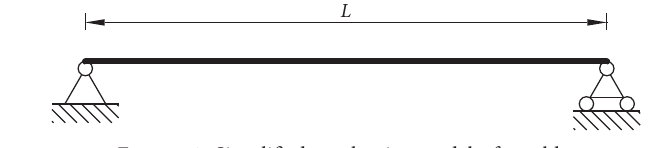
Figure 1: Simplified mechanics model of a cable.